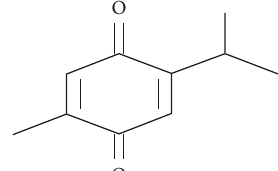
Figure 1: Structure of active principle (thymoquinone) of Nigella sativa